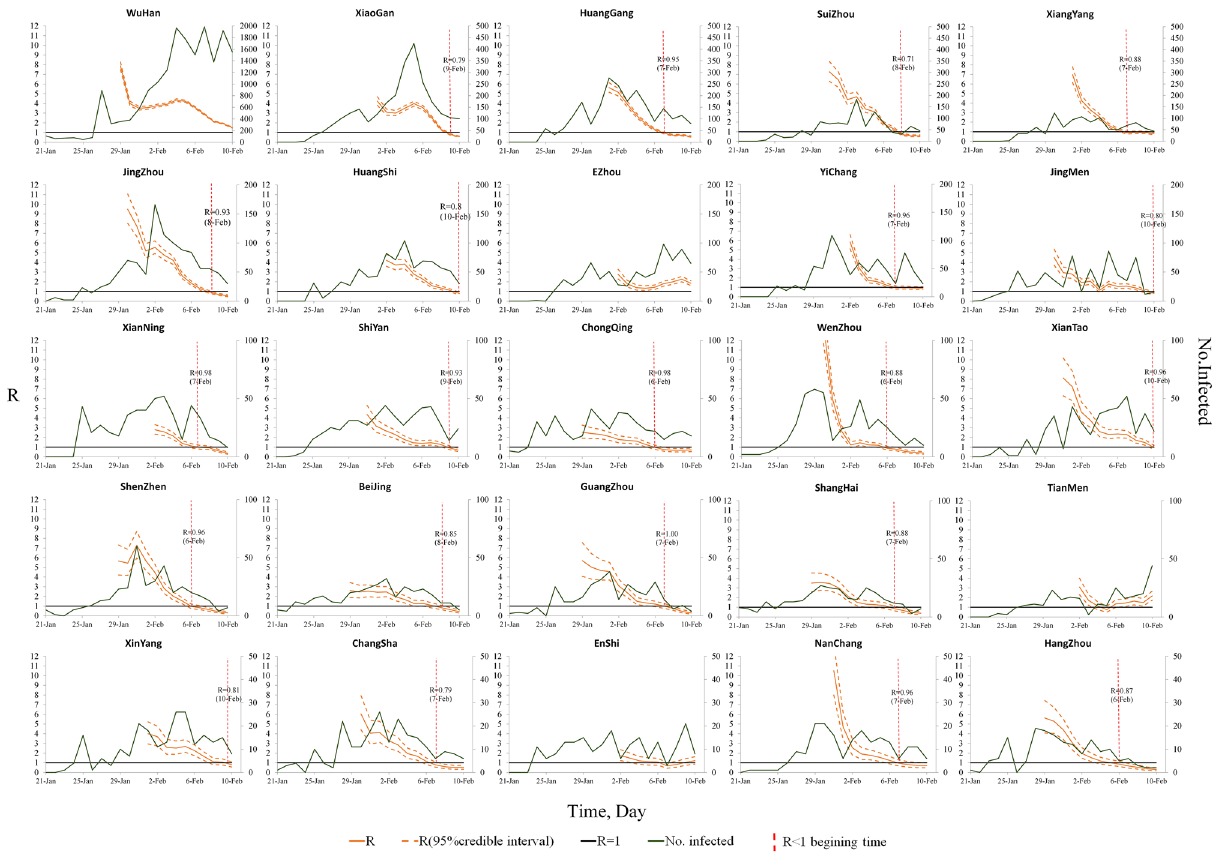
Figure 2. Epidemic curves and R change trends of the 25 worst-hit cities in China for